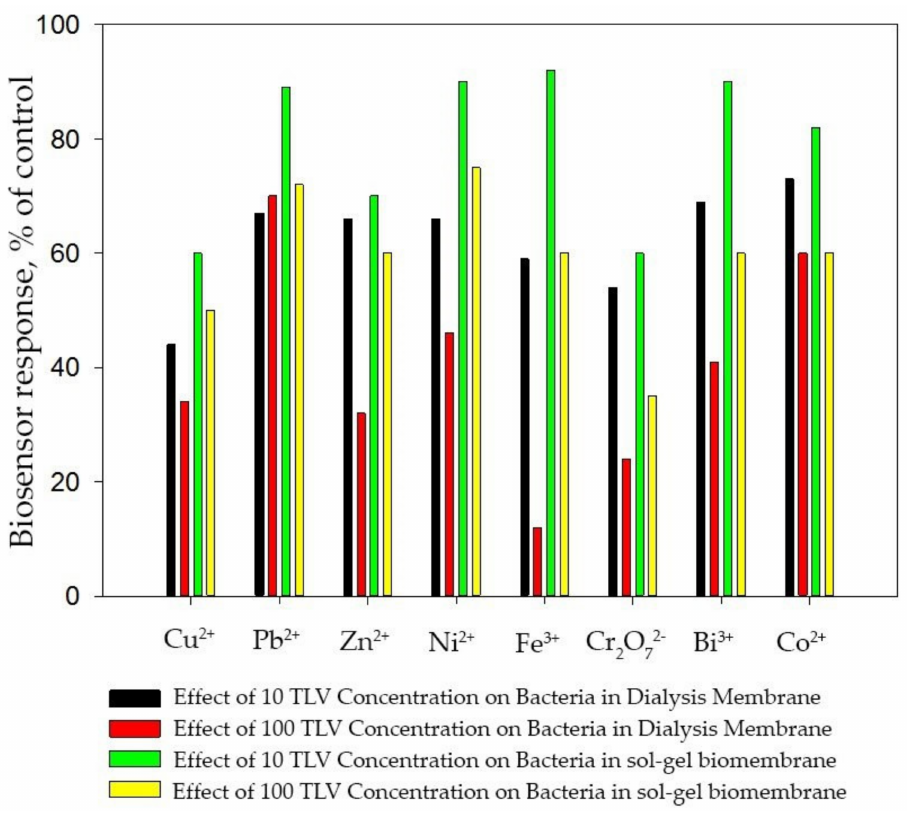
Figure 10. Effect of the content of heavy metal ions on the biosensor signal for the introduction of GGM using various methods of immobilization of bacteria on the electrode